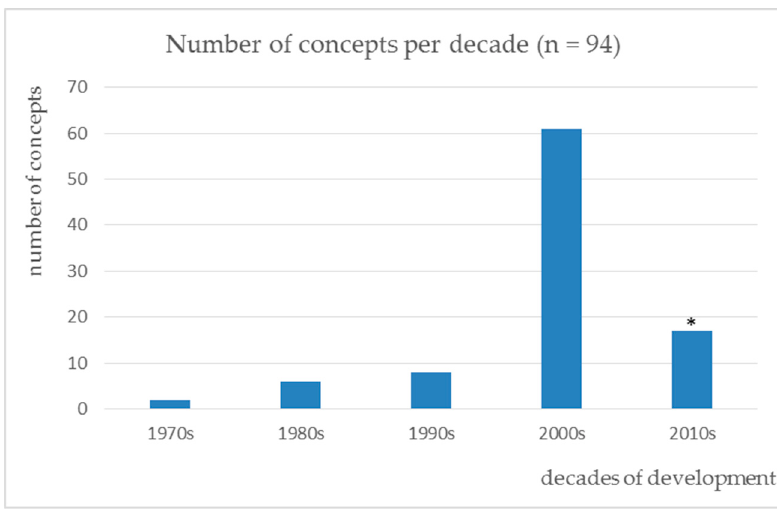
Figure 3. Number of BID concepts per decade from 1970 to 2012 (n = 94). *: The asterisk indicates that the underlying data cover only the first two years of the 2010s. Newly developed concepts and products in the years 2013–2019 must be added once they are researched.